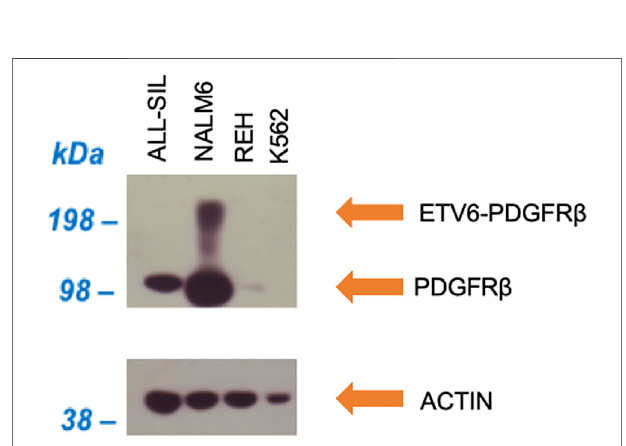
FIGURE 2 | Western blot against human PDGFRB (upper panel) and human actin (lower panel) as loading control.